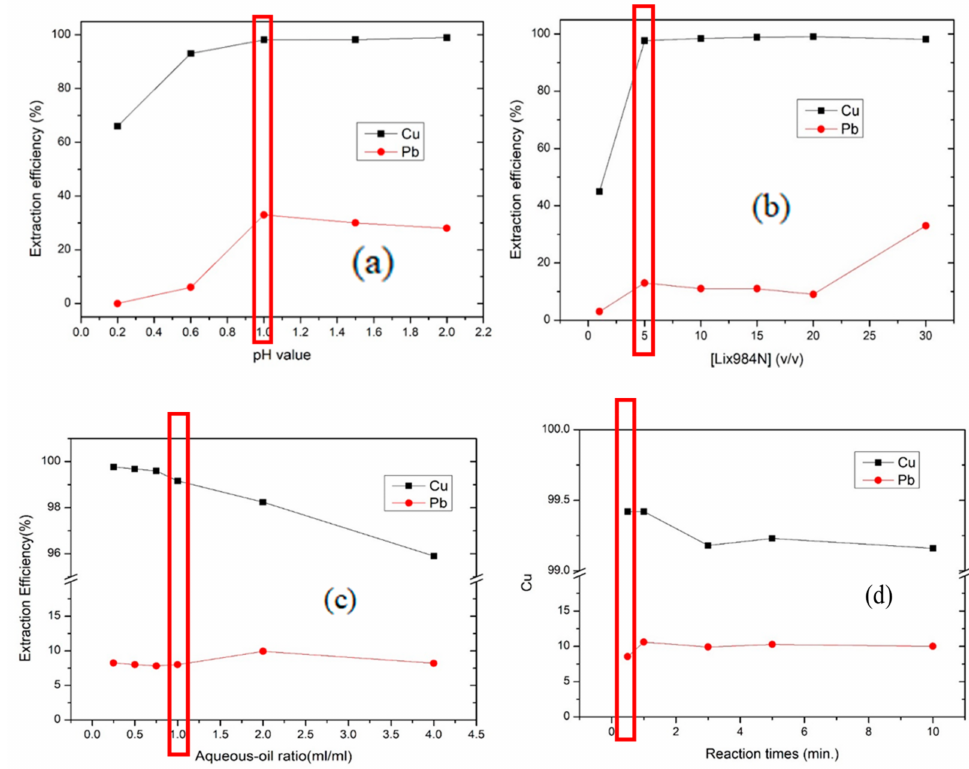
Figure 11. Effect of copper and lead extraction efficiency on ( a ) pH value, ( b ) LIX984N concentration, ( c ) A/O ratio, ( d ) reaction time.